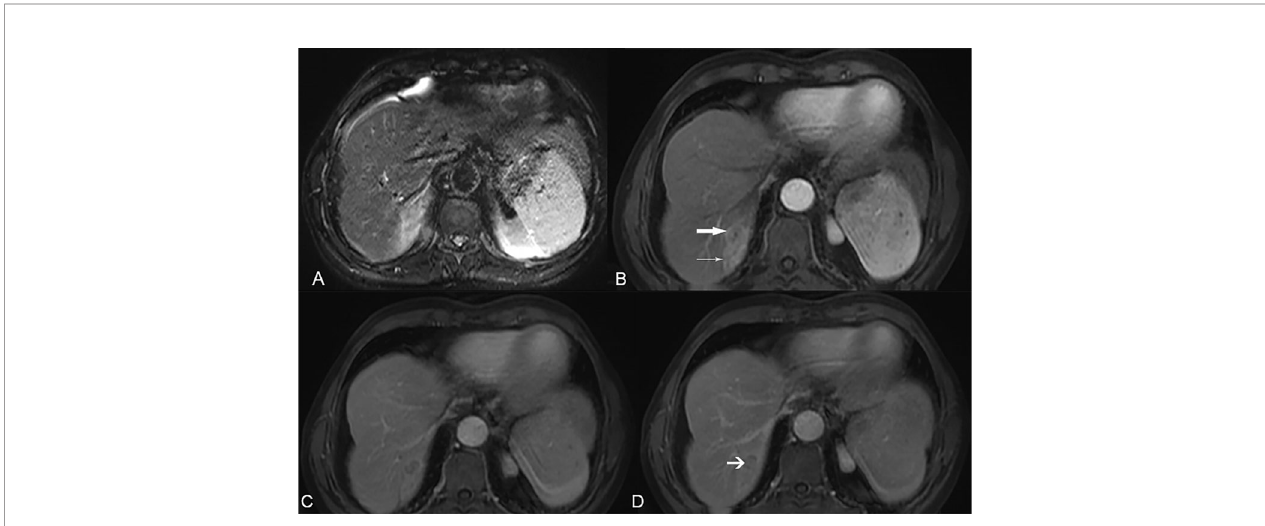
FIGURE 4 | A 61-year-old male patient with hepatitis B-related liver cirrhosis and cHCC-CCA is categorized as LR-M category. (A) T2-weighted image shows a 36- mm nodule with heterogeneous hyperintensity in hepatic segment VIII. (B) The arterial phase shows peripheral enhancement (arrow) and tumor thrombus in the bile duct (thin arrow) on contrast-enhanced T1-weighted imaging with the contrast agent Gd-DTPA. (C) The portal venous phase and (D) delay phase show targetoid appearance and the arrow shows progressively delayed central